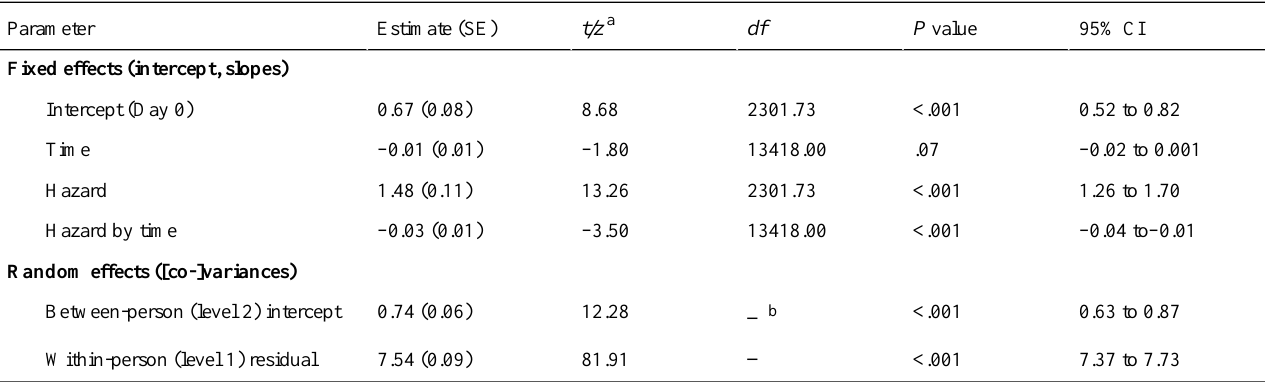
Table 3. Parameter estimates for linear growth model of drinks per day as a function of hazard and nonhazard Alcohol Use Disorders Identification Test group membership.